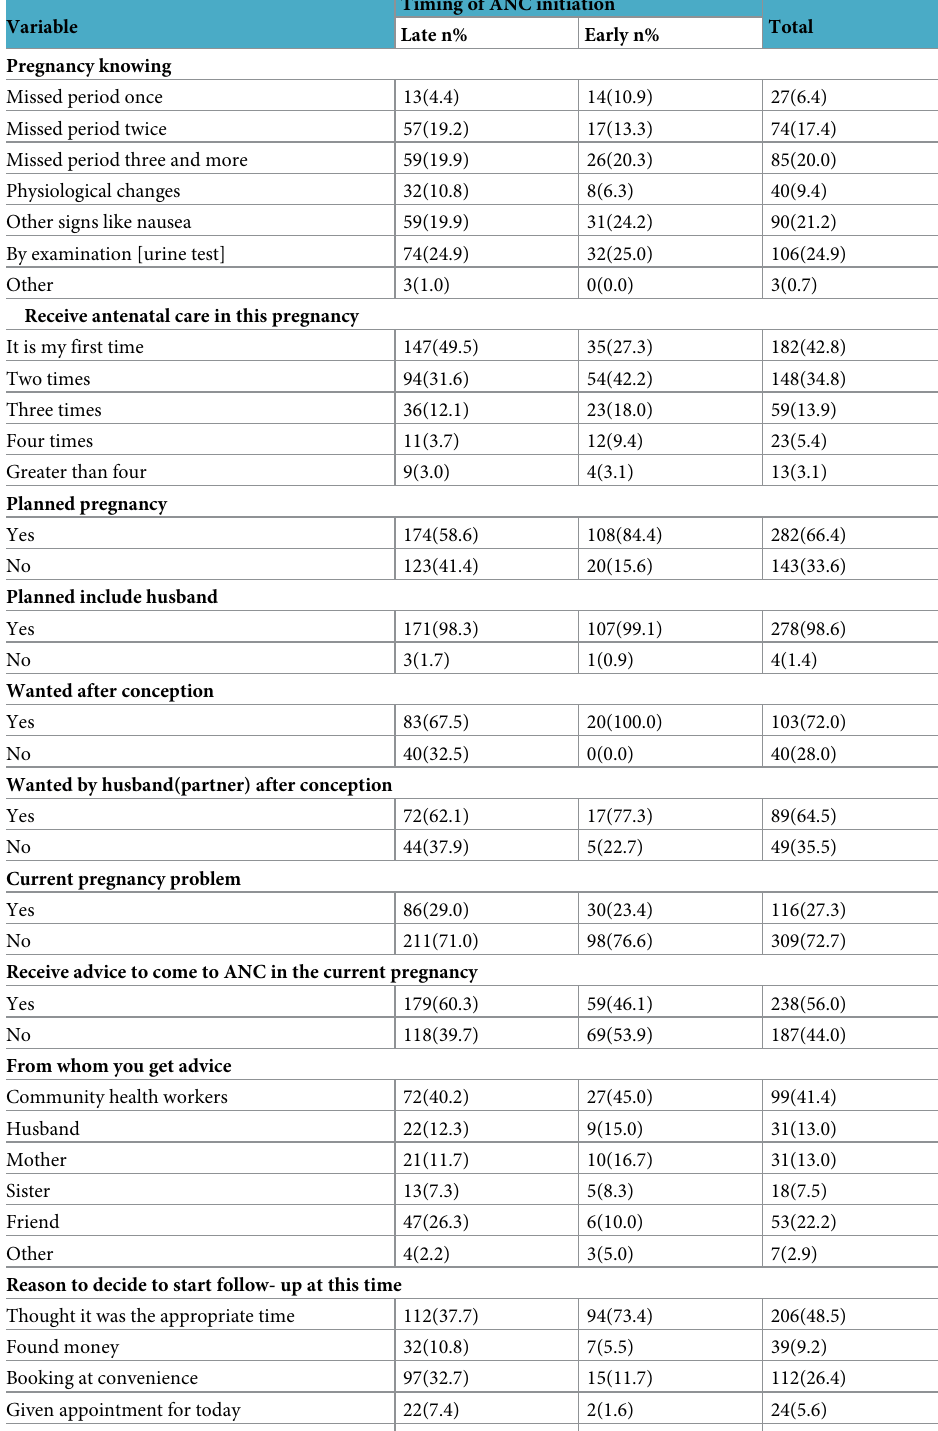
Table 3. History of current pregnancy and ANC of the study participants visiting health institution for ANC ser- vice in Mizan-Aman town, southwest Ethiopia